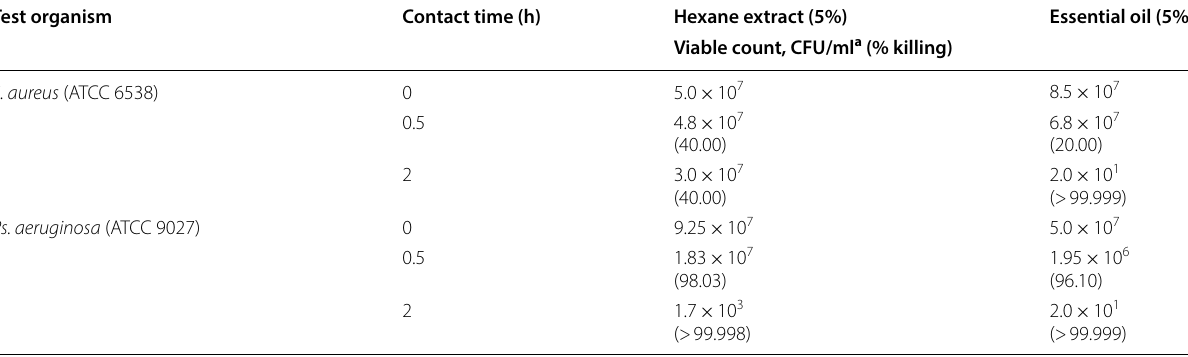
a Average of three determinations carried out by surface viable count method at RT (24 °C)